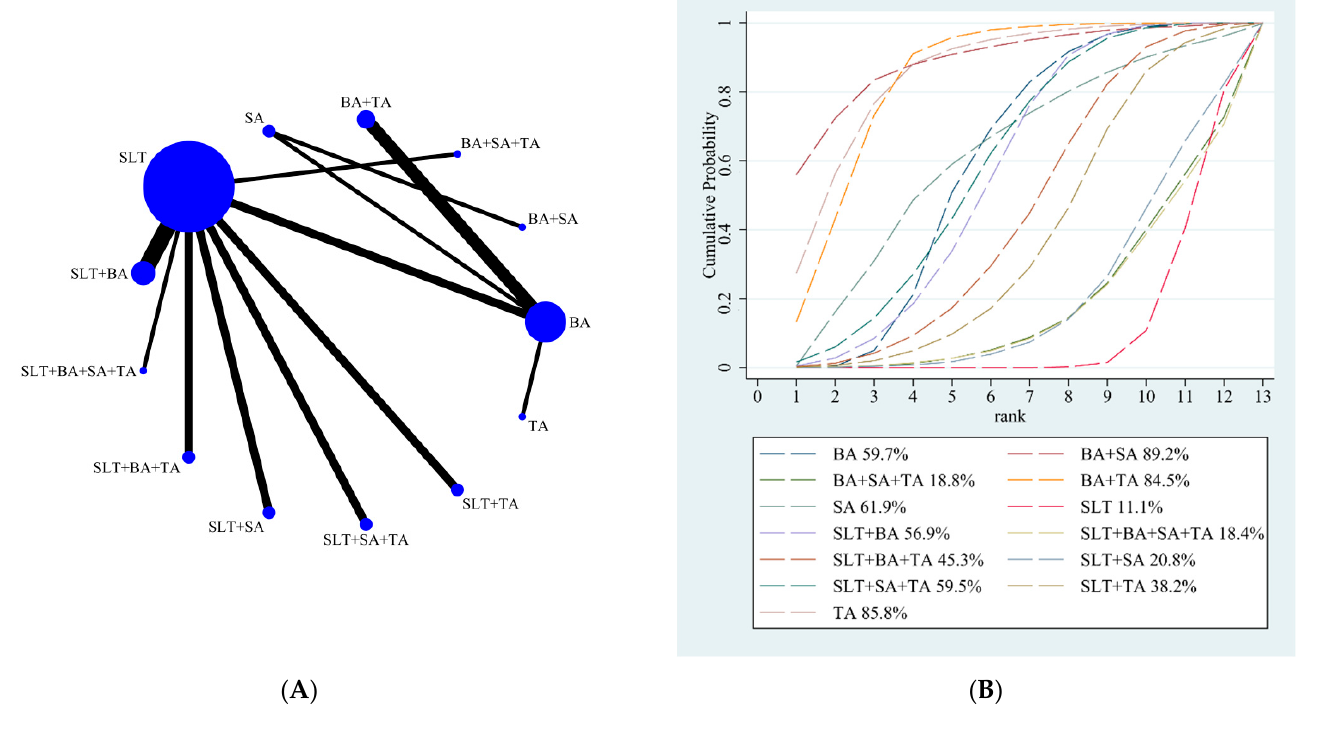
Figure 5. ( A ) NMA figure for the repetition score. ( B ) SUCRA plot for the repetition score.